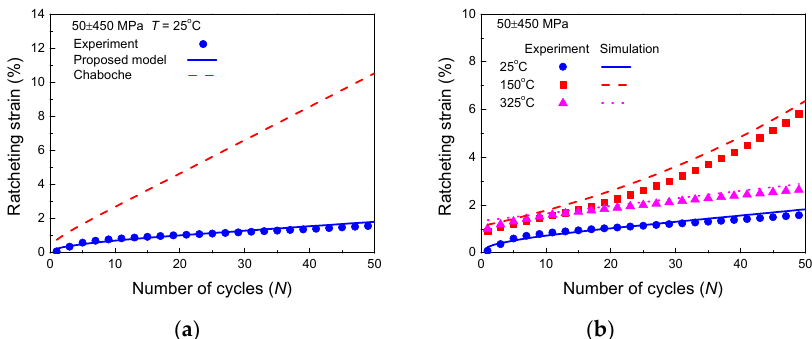
Figure 5. Comparisons between experimental and simulated ratcheting strain by: ( a ) Chaboche model and the proposed model at 25 °C; ( b ) the proposed model at different temperatures.